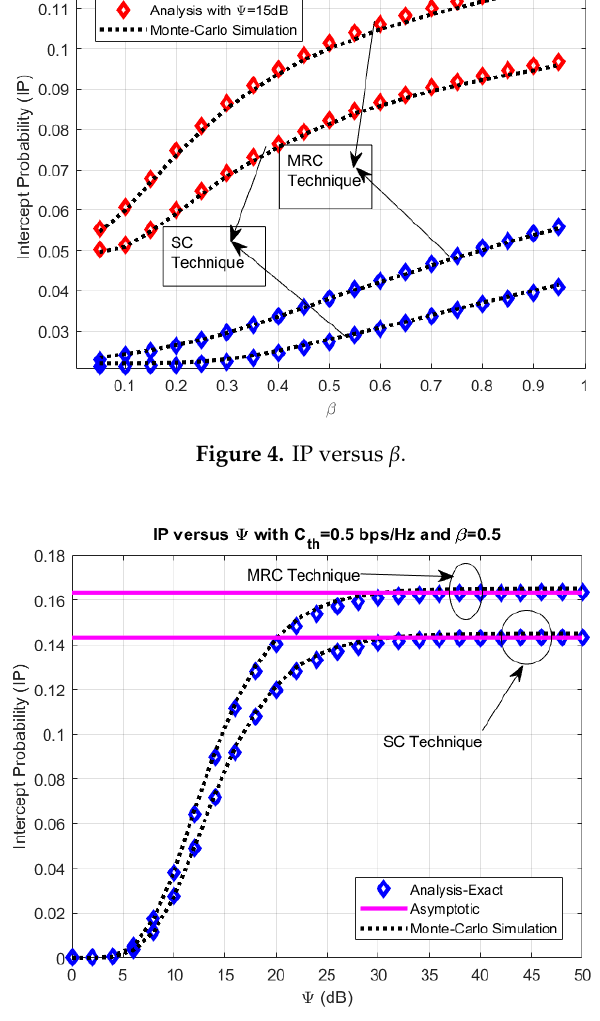
Figure 4. IP versus β .